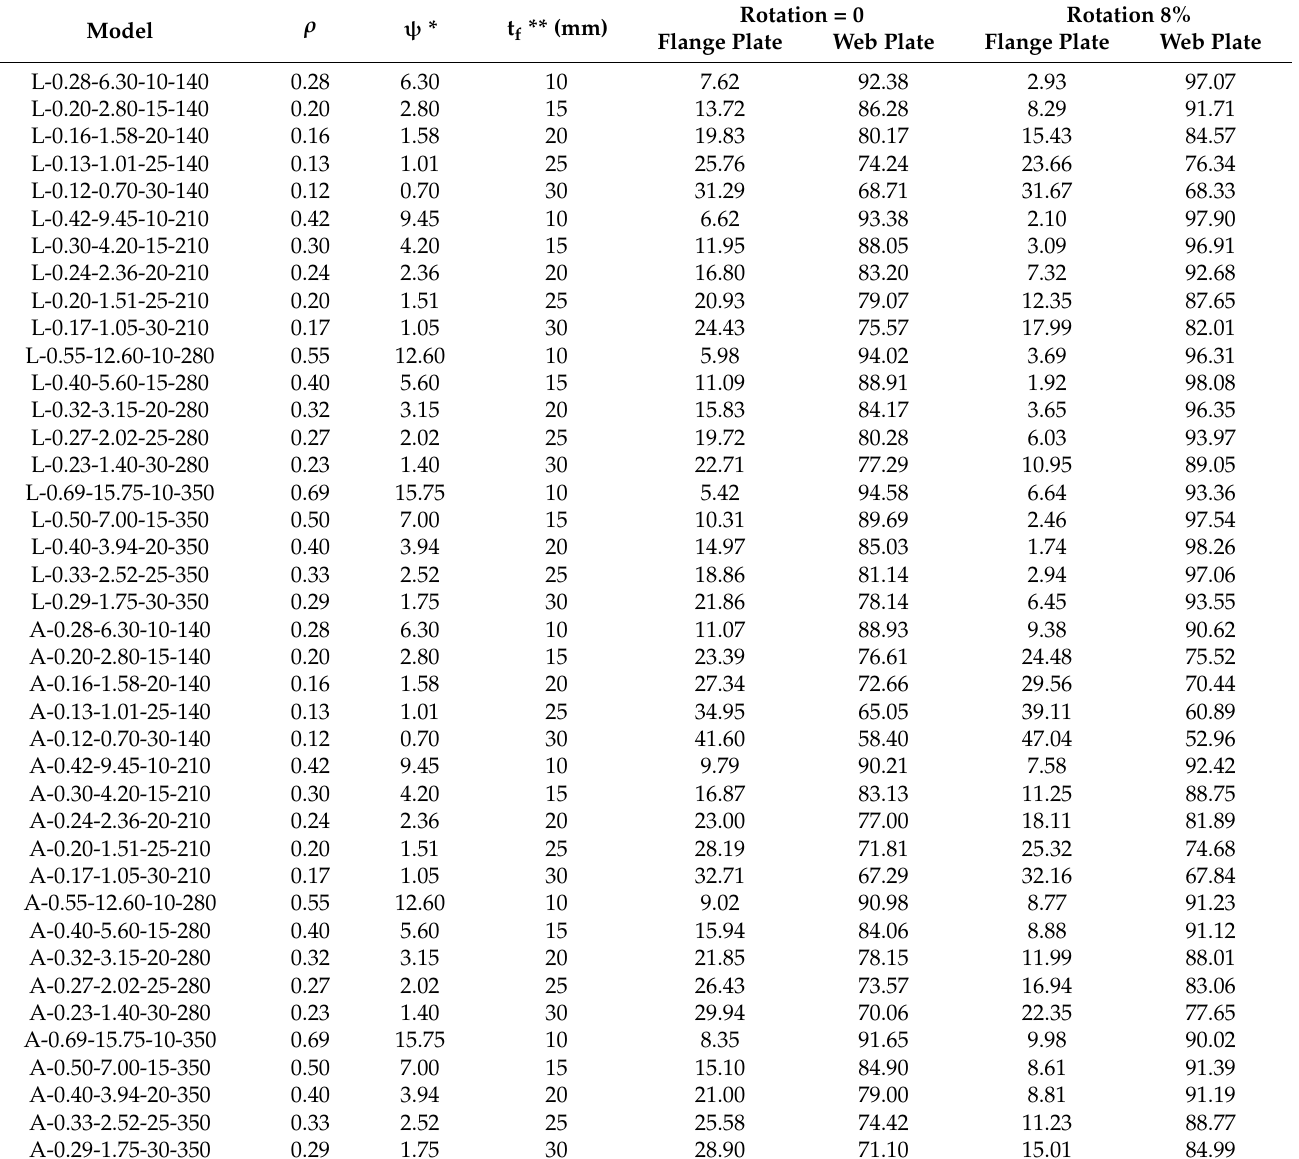
Table 5. Comparing the contribution of the flange to the damper shear